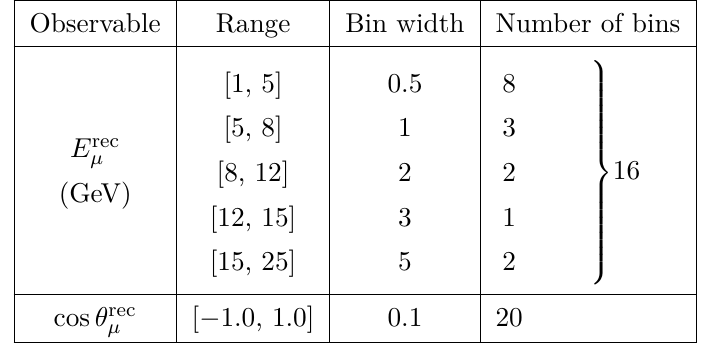
and cos θ rec of µ − and µ + events. µ µ